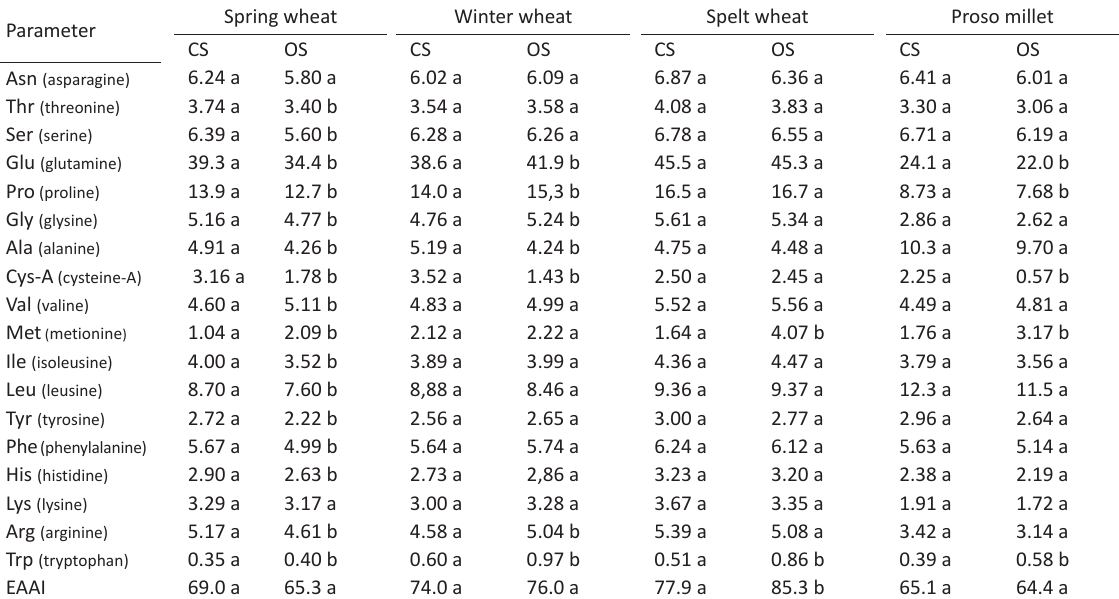
Table 4. Amino acid content in cereal grain (g kg -1 ) —mean for 2011–2013 Spring Parameter